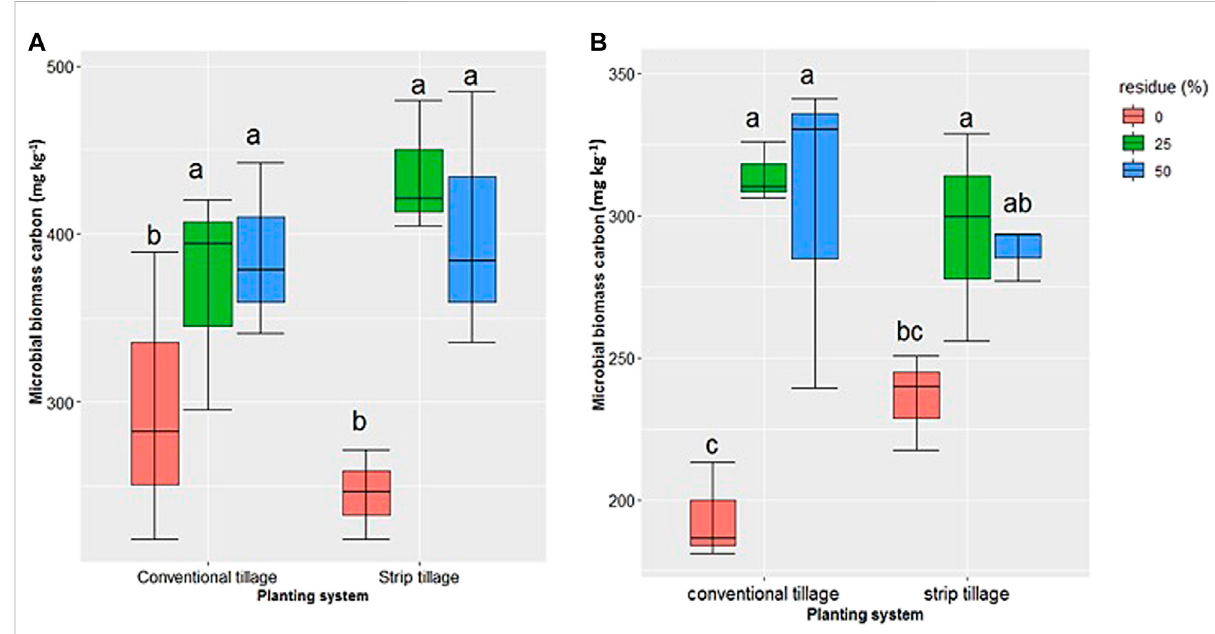
FIGURE 9 Allocationofmicrobialbiomassat0 – 5 cm (A) and5 – 10 cm (B) depthsasin fl uencedbyresidueretention,andtillage-basedcropestablishment practices after 2-year of rice-maize